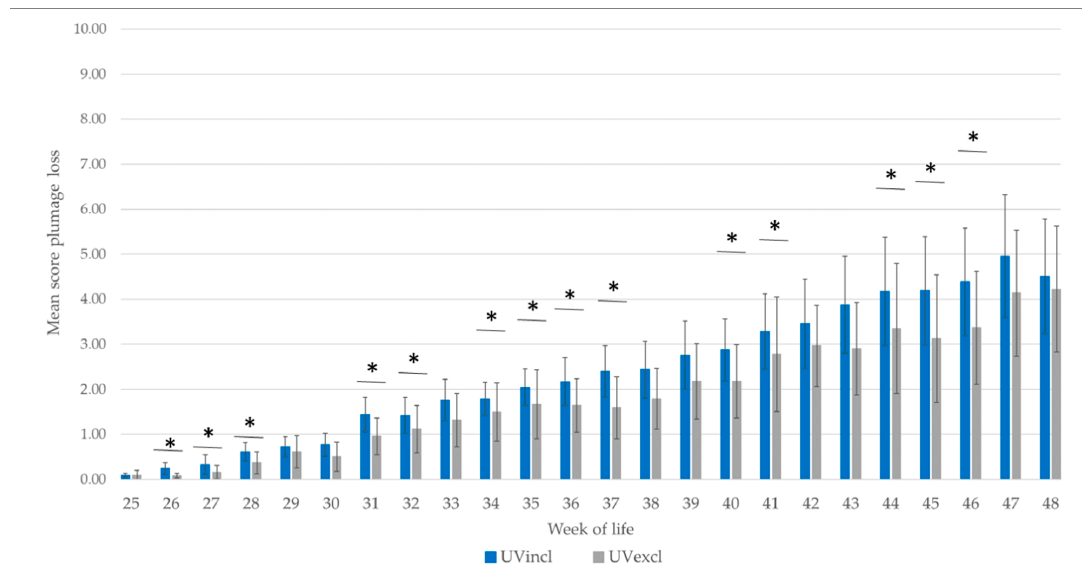
Figure 5. Mean plumage score of the whole body in hens ( n = 200 hens/lighting group and week; Score 0 = intact plumage) during production period dependent on light spectrum (UV-A light +/ − ). The group with additional UV-A (UVincl) had a higher mean plumage score compared to the group without UV-A lighting (UVexcl). * Significant differences in the mean Plumage Score ( p < 0.05; WL: 26, 27, 28, 31, 32, 34, 35, 36, 37, 40, 41, 44, 45, 46).